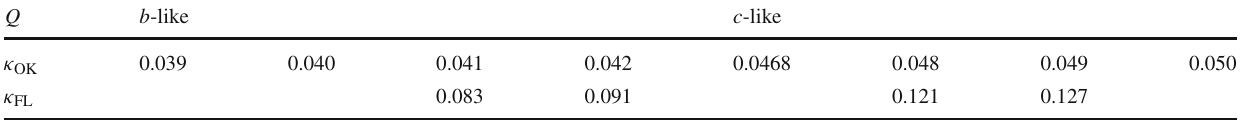
Table 1 Input hopping parameters κ OK for the OK action and κ FL for the Fermilab action. Note that these inputs are exact and are not cho- sen by tuning with a physical observable. The resulting kinetic meson massescovertheregionofphysicalheavy–lightandquarkoniummasses